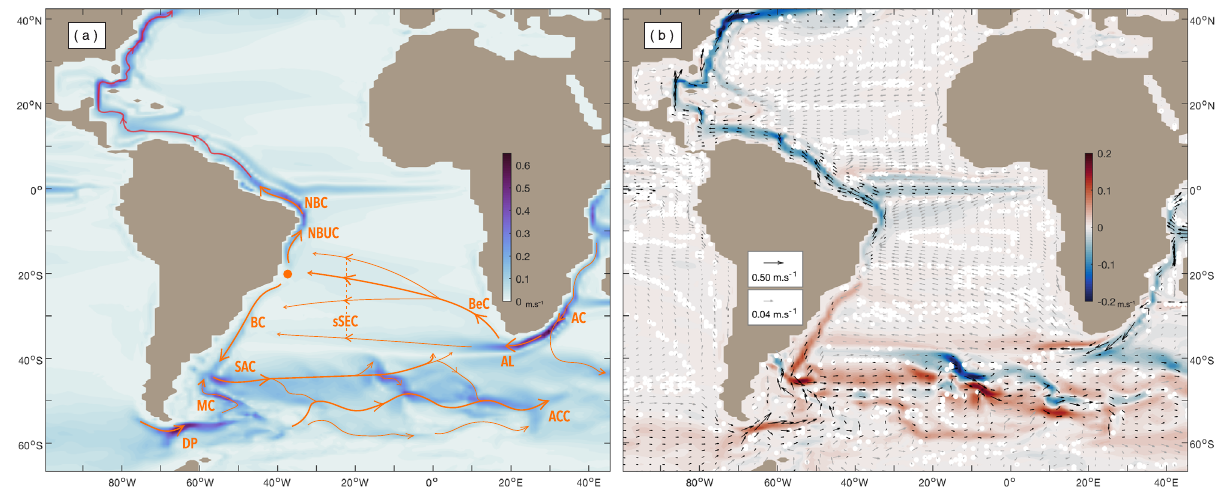
Fig. 1 Schematic of the South Atlantic circulation and projected changes in the transport of ocean currents along the 20th and 21st centuries, as according to the ensemble mean of CESM1-LE simulations. a Mean 1920 – 2100 fl ow fi eld represented by the absolute magnitude of horizontal velocities averaged over the upper 985-m layer (background shading) superposed by a schematic of the South Atlantic circulation including the oceanographic features and currents mentioned in the text. DP, Drake Passage; MC, Malvinas Current; SAC, South Atlantic Current; ACC, Antarctic Circumpolar Current; AC, Agulhas Current; AL, Agulhas Leakage; BeC, Benguela Current; sSEC, southern South Equatorial Current; NBUC, North Brazil Undercurrent; NBC, North Brazil Current; BC, Brazil Current. The orange circle at ~20 ∘ S, 40 ∘ W represents the mean sSEC bifurcation latitude. b Ocean currents getting faster (red)/ slower (blue) from 1920 to 2100. Superposing vectors denote the 1920 – 2100 mean horizontal velocities averaged over the upper 985-m layer, giving a perspective of the mean fl ow intensity and direction. The background shading represents the total trends along 1920 – 2100 of the absolute magnitude of upper 985 m horizontal velocity anomalies with respect to the 1920 – 1970 base period. Black (gray) vectors are plotted over regions where the absolute velocity magnitude is above (below) the mean value (0.035m.s − 1 ), for clarity. Gray vectors are scaled by a factor of 50, in comparison with black vectors. Red (blue) indicates regions where velocity magnitudes tend to increase (decrease). Grid points where trends are not statistically signi fi cant at the 95% con fi dence level are marked with white